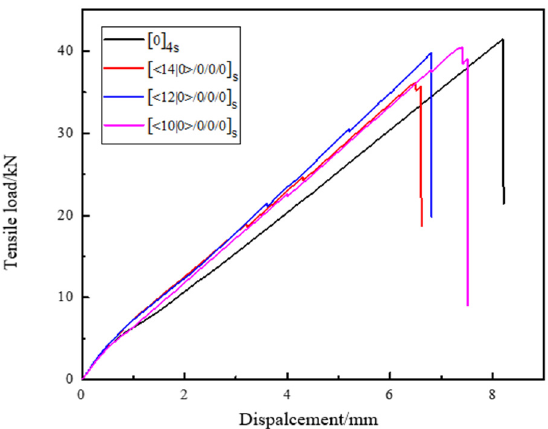
Figure 11. Tensile load–displacement curve of linear layup and curved layup specimens.